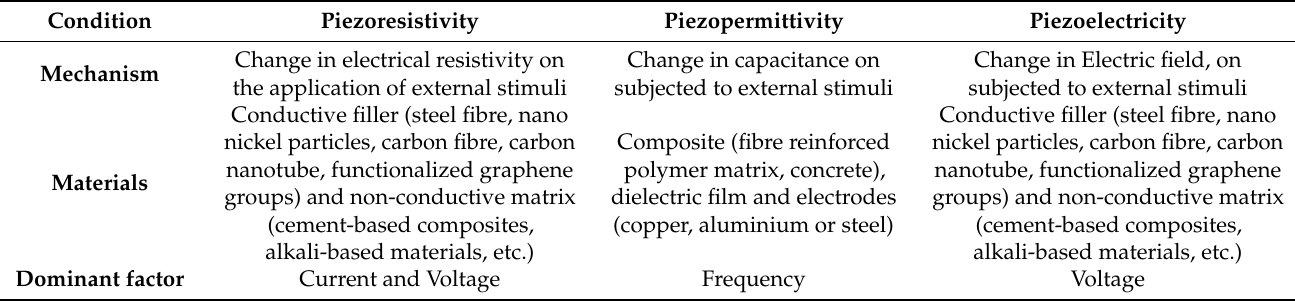
Table 2. Properties adopted for different methods of electromechanical principle.